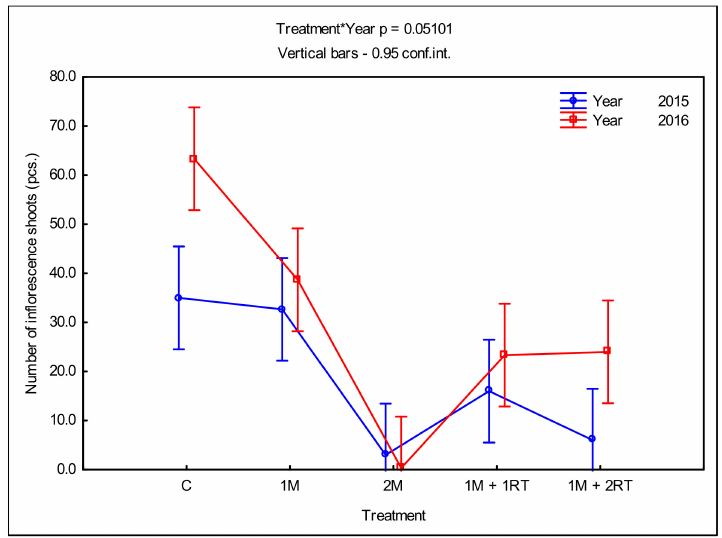
Figure 10. Mean number of goldenrod shoots with inflorescences per 1 m 2 , depending on the type of mechanical treatment. The following symbols denote the research treatments: C: control; 1M: one-time mowing; 2M: two-time mowing; 1M + 1RT: one-time mowing with one-time rotary tilling;